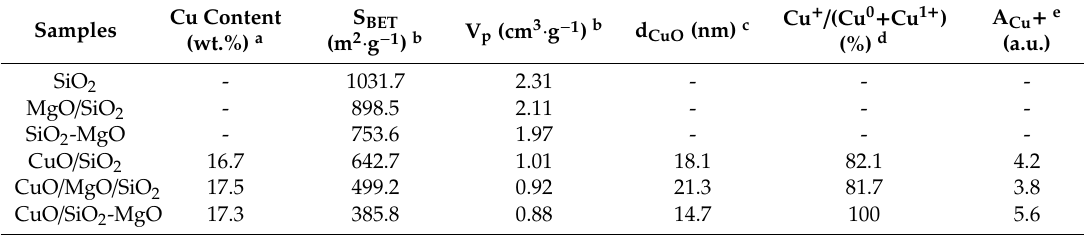
Table 1. Structural and textural data for the CuO-Bi 2 O 3 catalysts.